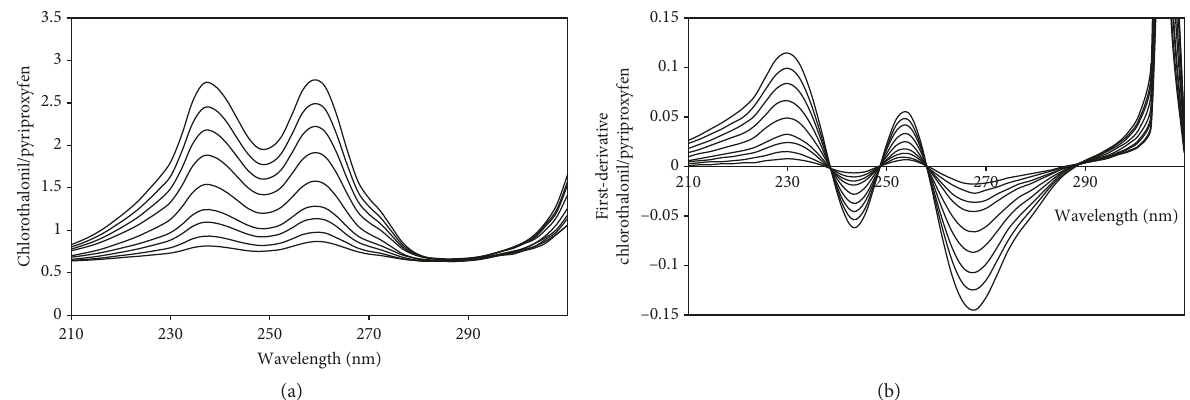
Figure 10: Ratio spectra (a) and first derivative ratio spectra (b) of chlorothalonil (0.5, 1, 1.5, 2, 3, 4, 5, 6, and 7 μ g · mL − 1 ) when 15 μ g · mL − 1 of pyriproxyfen was used as divisor in methanol ( ∆ λ � 4nm).